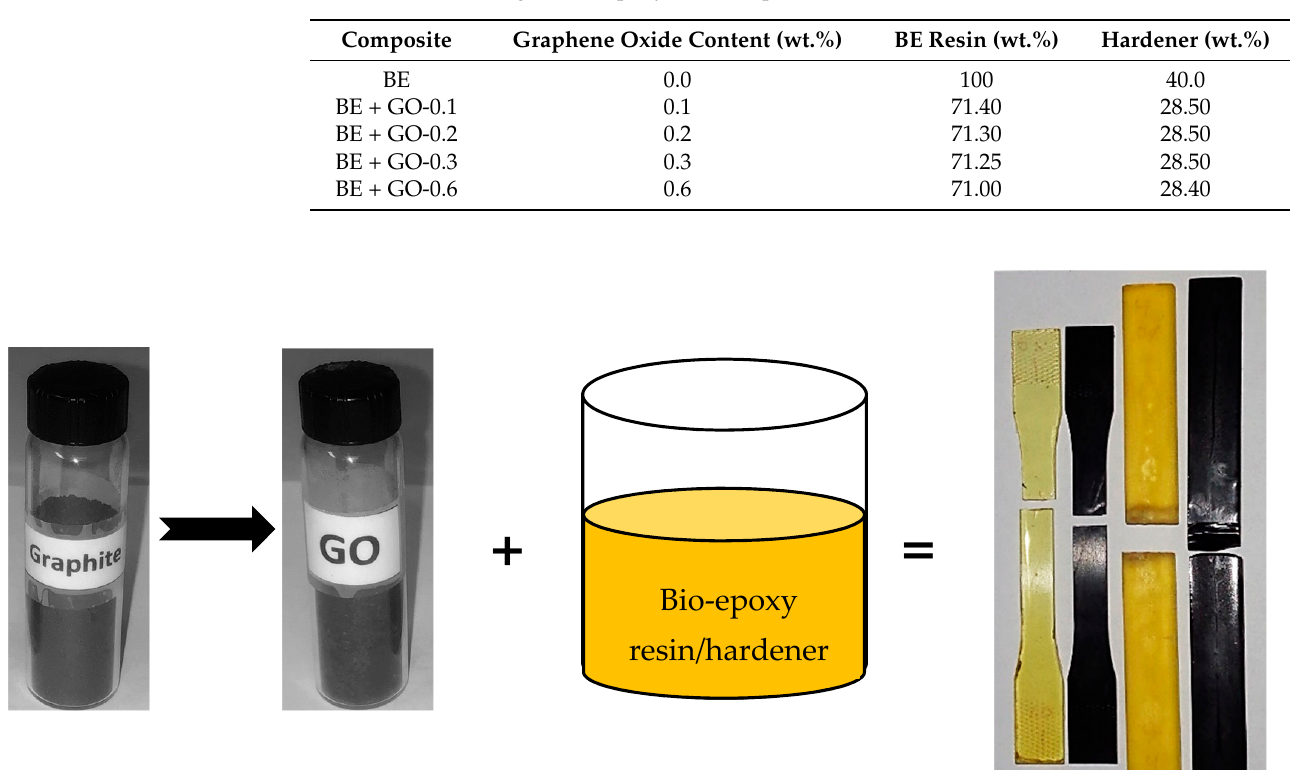
Table 1. Filler loadings in bio-epoxy (BE) composites.